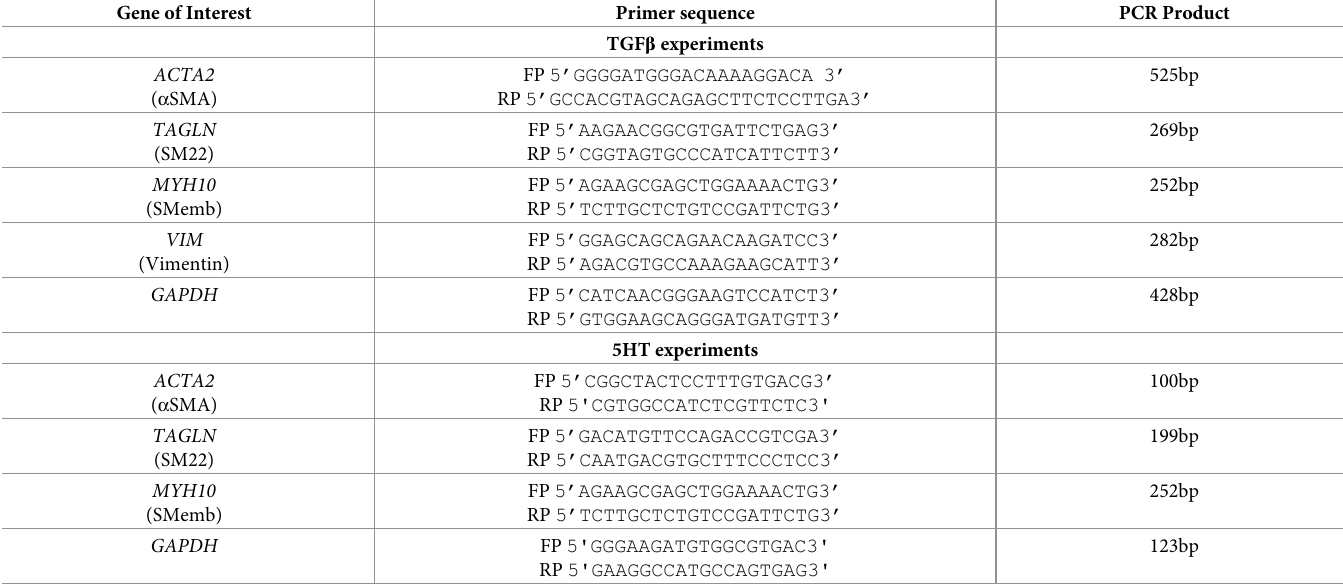
Table 1. Primer sequences used for RT-PCR (TGF β ) and qPCR (5HT). Gene of